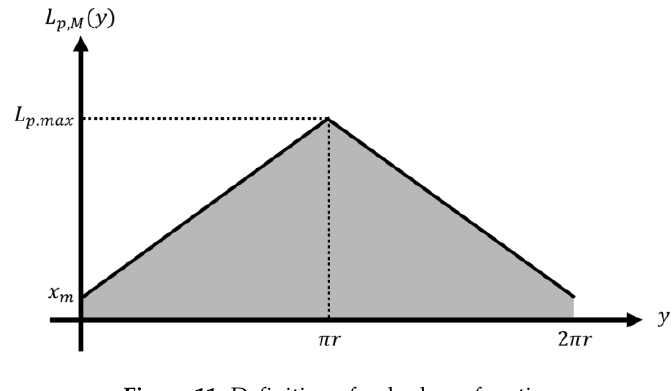
Figure 11. Definition of pole shape function.